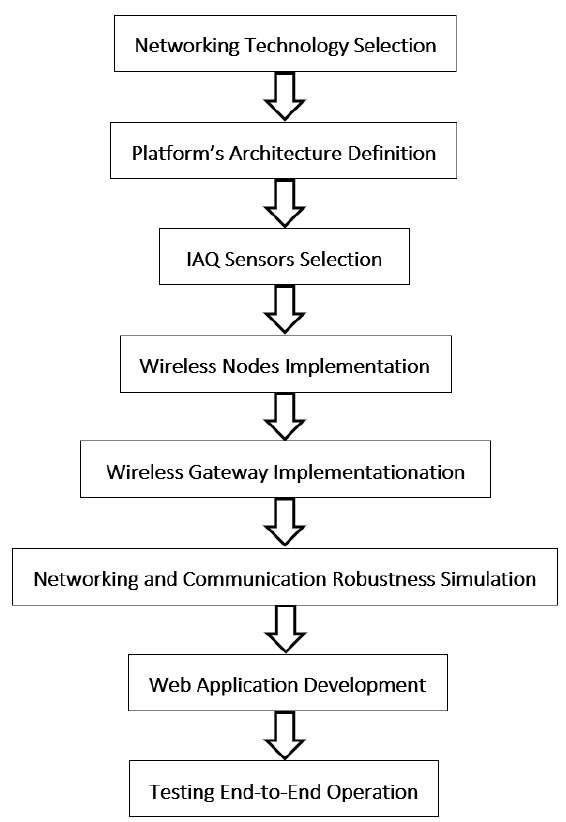
Figure 1. Methodology followed for realizing the proposed early warning system for COVID-19 infections based on low-cost Indoor Air Quality (IAQ) sensors and LPWANs.